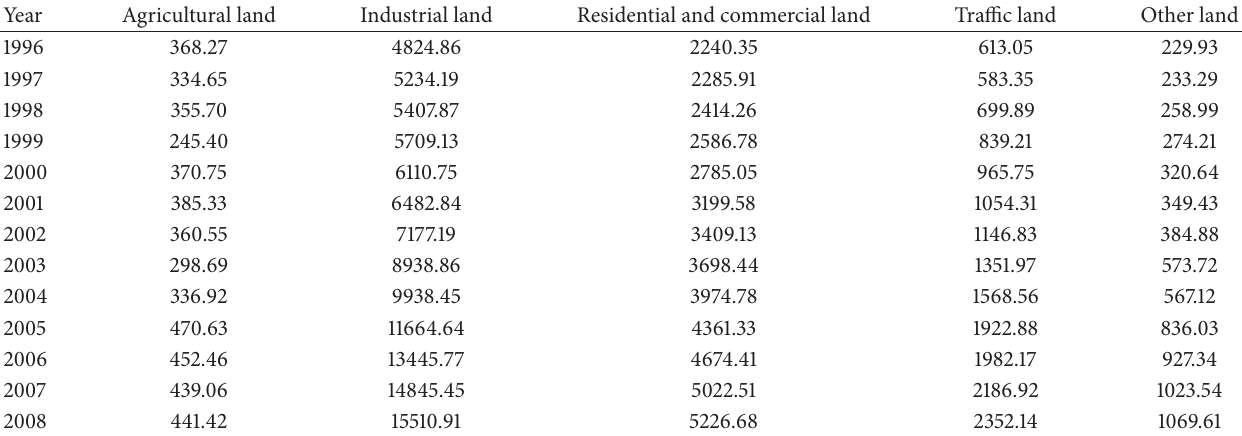
Table 10: Energy consumption in different types of land use (10 4 ton standard coal